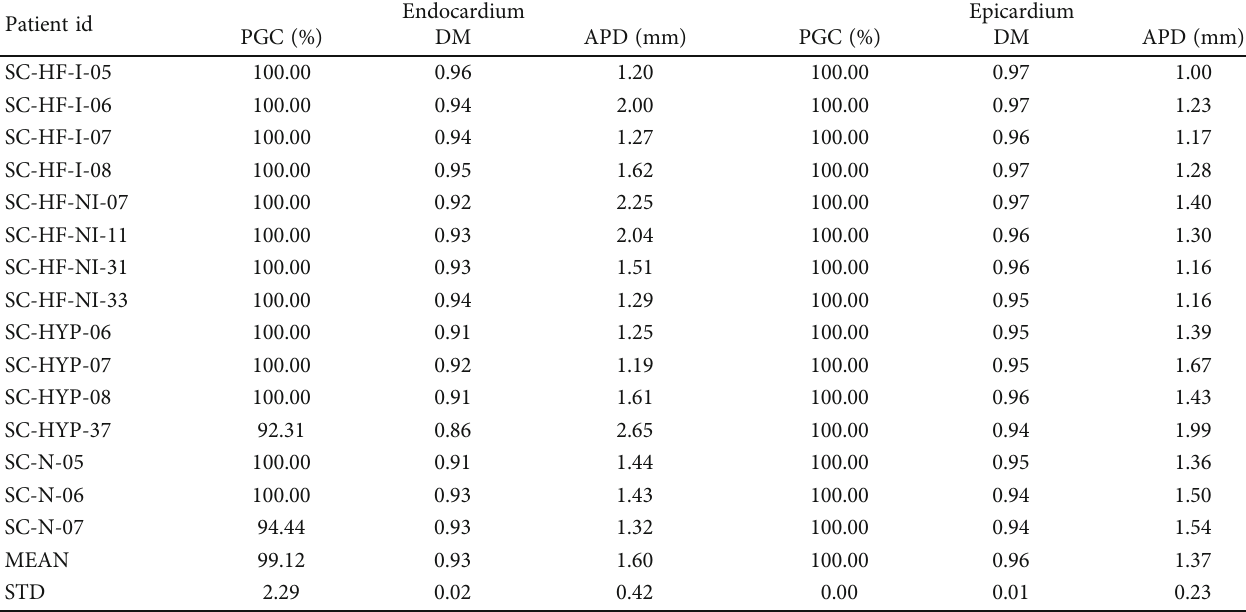
Table 1: Segmentation results on all 15 test cases.